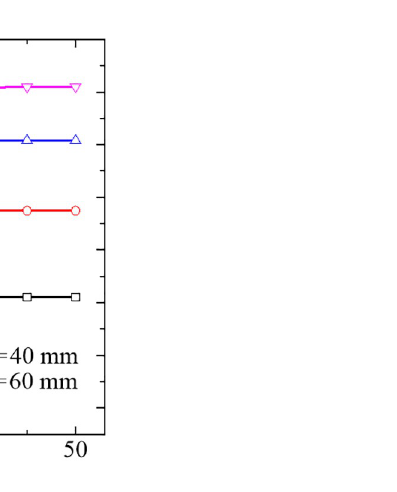
Fig 14. Variations of scale thickness of the four representative points in 50 s.